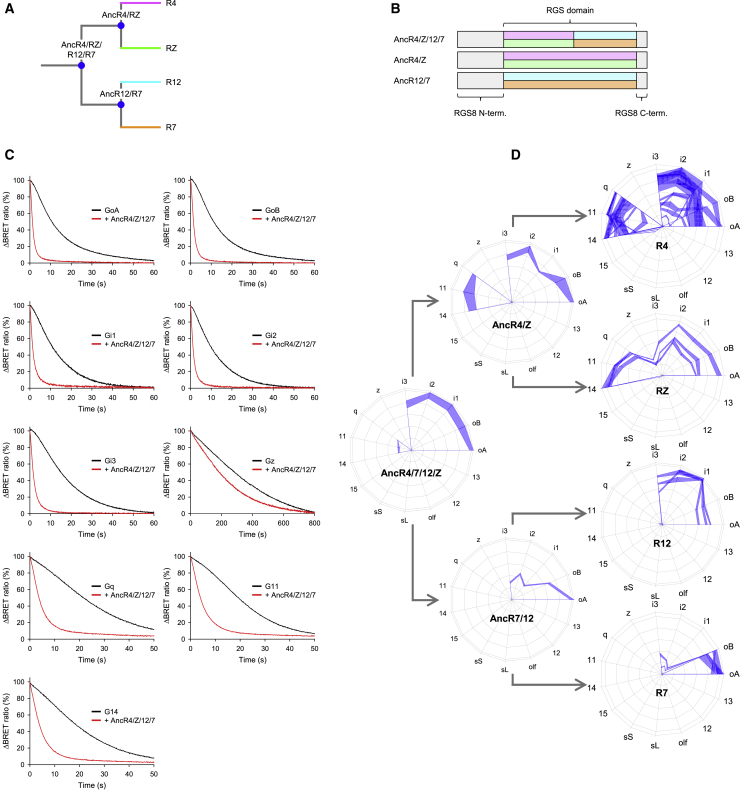
Engineering Gα-Selectivity Fingerprints by Ancestral Reconstitution of RGS Domain Sequences(A) Phylogenetic tree calculated on the basis of multiple sequence alignment of human RGS proteins and a stochastic model of sequence evolution.(B) Schematics of ancestral reconstitution strategy.(C) GAP activity of primordial AncR4/Z/12/7 on Gα subunits with statistically significant activity.(D) Gα selectivity fingerprints of 3 ancestral RGS proteins and extant human RGS proteins.